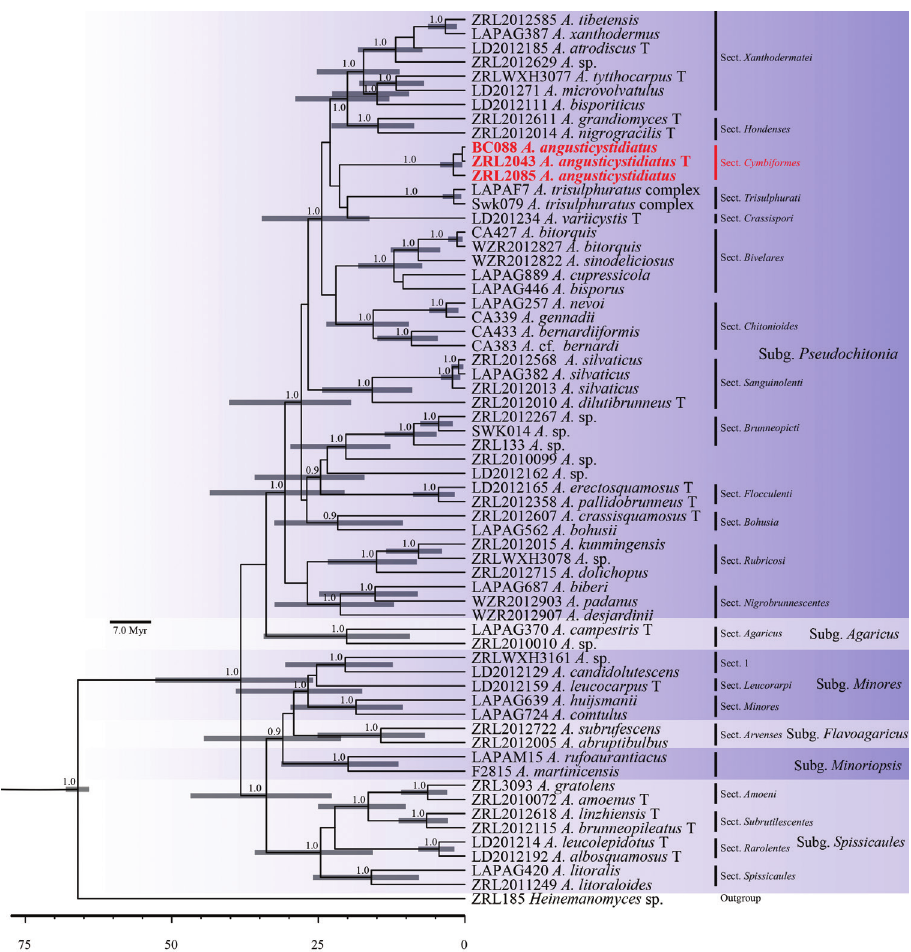
Figure 2. Maximium Clade Credibility tree of genus Agaricus based on ITS, LSU and tef1- α gene se- quences with the outgroup Heinemannomyces sp. Posterior probability values equal or above 0.9 are an- notated at the internodes. The 95% highest posterior density of divergence time estimation are marked by horizontal